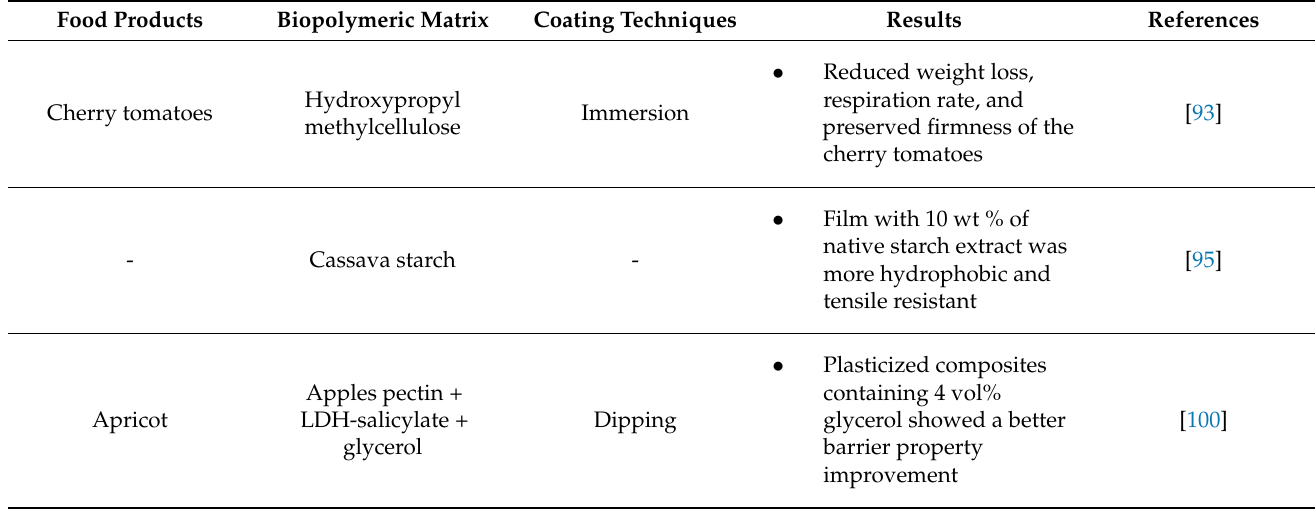
Table 2. Application of edible packaging in food